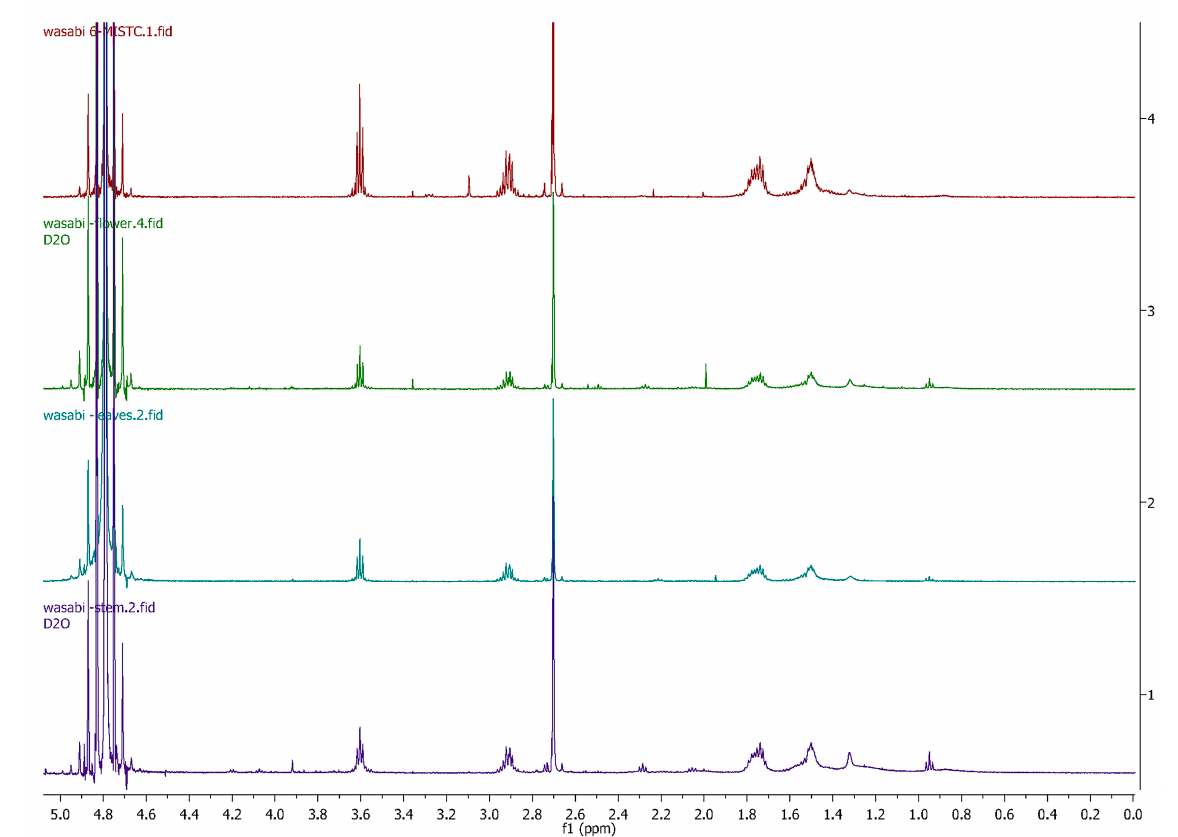
Figure 2. 1 H NMR of 6-MSITC compared in E. japonicum flower, leaves and stem recorded in D 2